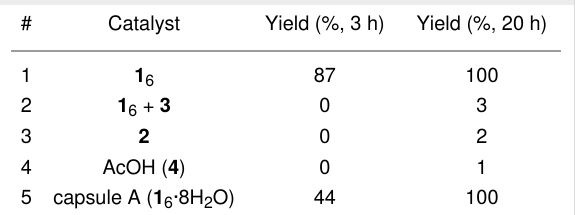
Table 2: Dehydration of 1,1-diphenylethanol to 1,1-diphenylethylene 3 h and 20 h at 60